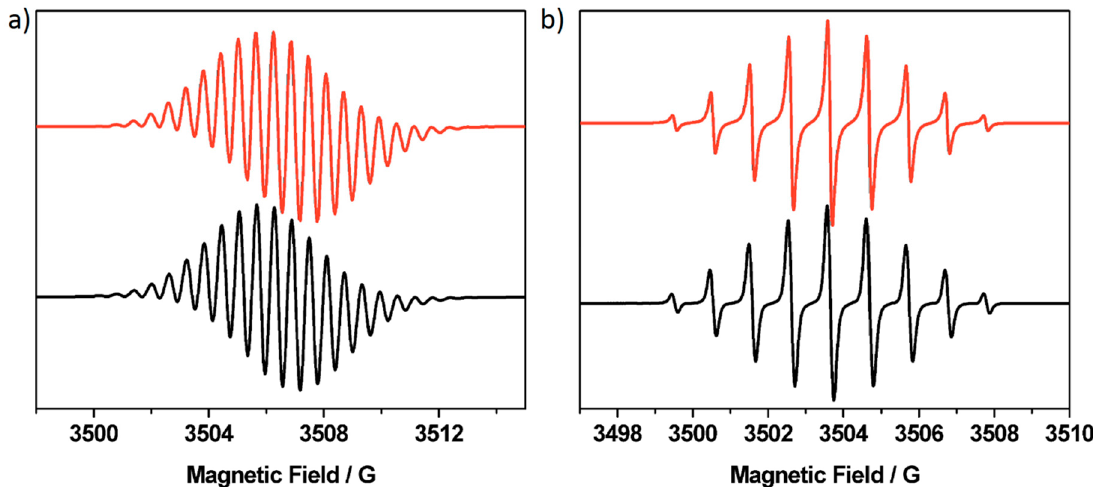
Figure 3. Experimental (black) and simulated (red) X-band EPR spectra of: ( a ) [P5A] + and ( b ) [P4A1Q] − . Samples were electrogenerated from the parent molecules at 273 K as CH 2 Cl 2 solutions containing [ n Bu 4 N][BF 4 ] (0.4 M) as the supporting electrolyte. Spectra were recorded at ambient temperature. Simulated spectra were generated using the parameters listed in Table